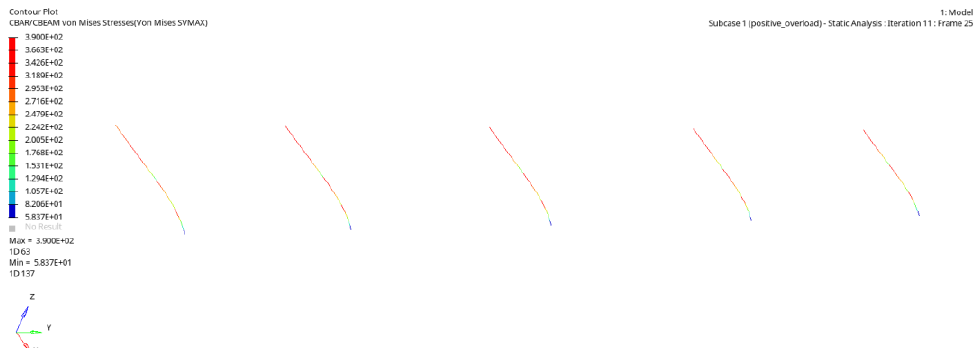
Figure 25. Stress of curved beam (condition D).